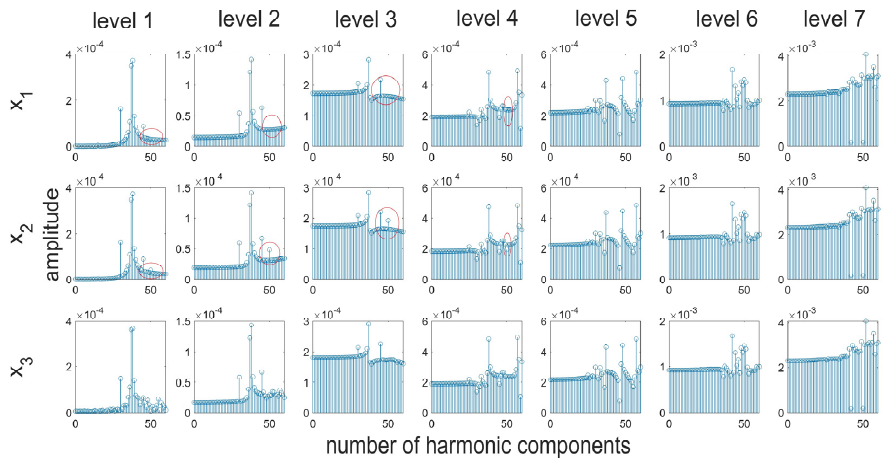
Figure 7. A spectrum of signals for seven levels of analysis.